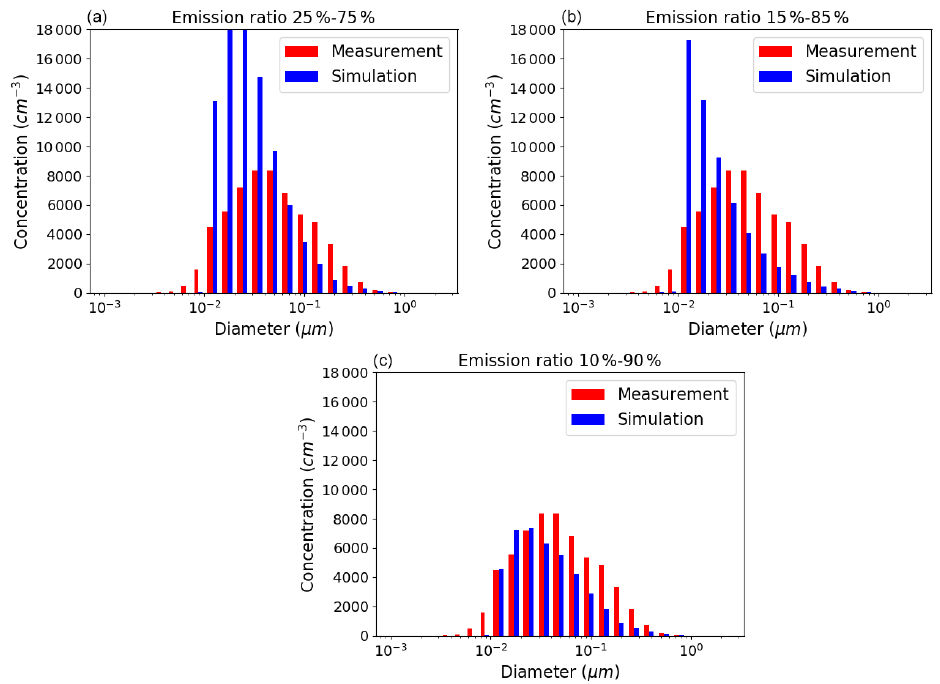
Figure 3. Average number concentration between 2 July 00:00UTC and the 4 July 06:00UTC, simulated with an emission ratio of 25%– 75% (a) , 15%–85% (b) , and 10%–90% (c) . The simulated concentrations are in blue, while the concentrations measured with the TDMPS are in